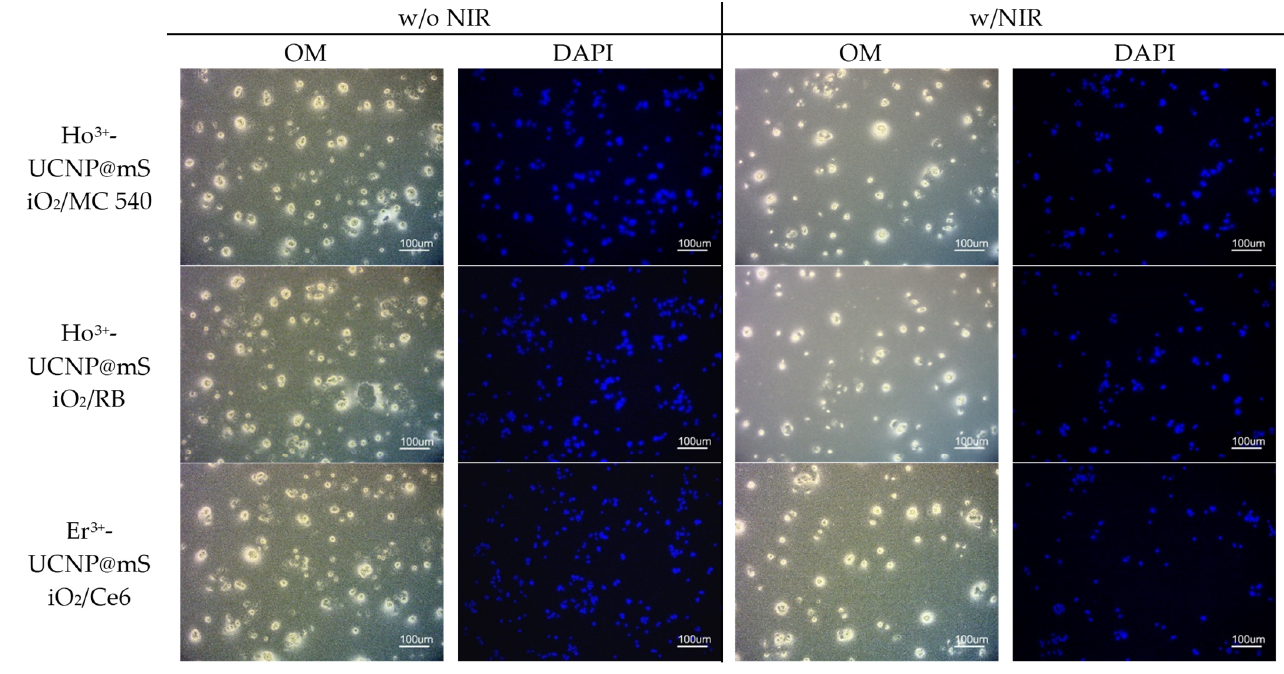
Figure 10. Optical and DAPI-stained images (from top to bottom) of Ho 3+ -UCNP@mSiO 2 /MC 540, Ho 3+ -UCNP@mSiO 2 /RB and Er 3+ -UCNP@mSiO 2 /Ce6 without ( left ) and with ( right ) NIR irradiation. All scale bars are in 100 μ m.